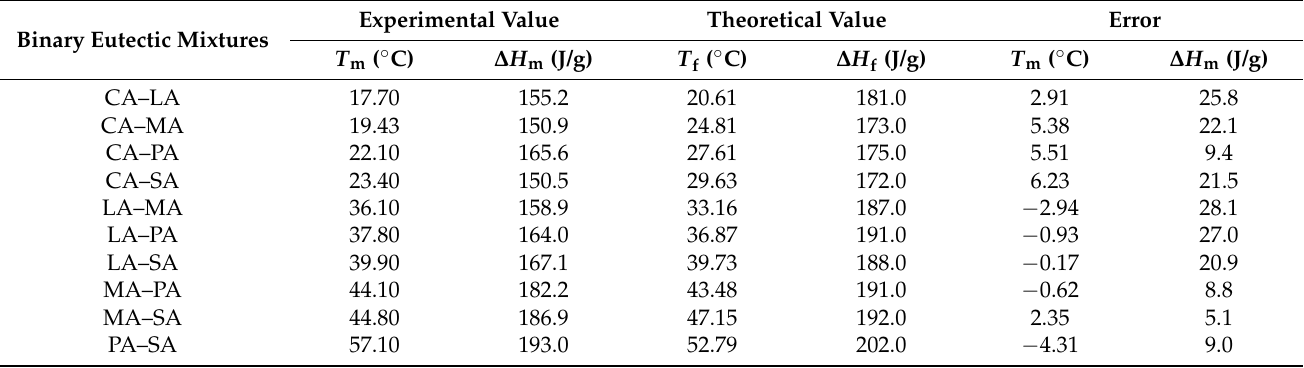
Table 5. Comparison of the theoretical and experimental values of thermal performance parameters of ten binary eutectic